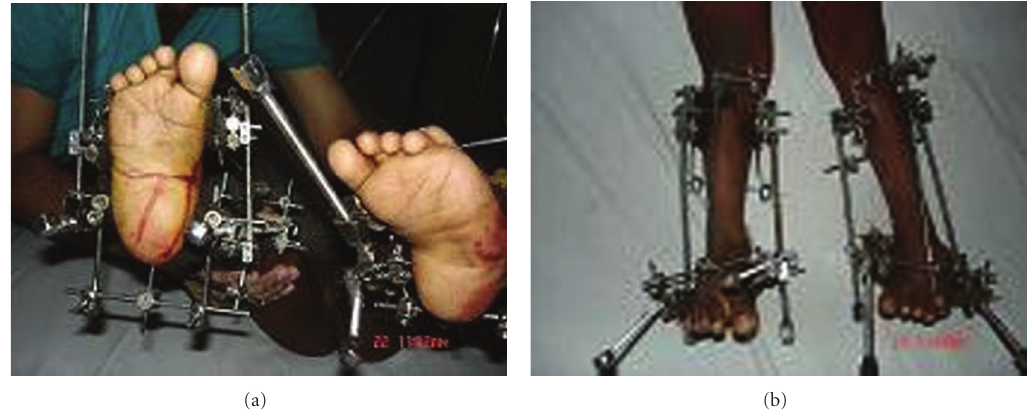
Figure 3: Clinical photos showing the fixator assembly in position before ligamentotaxis is